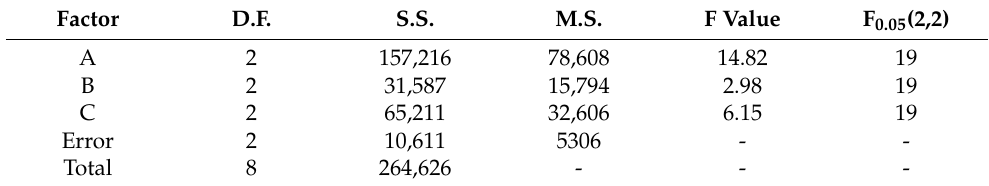
Table 5. ANOVA of the material removal rate.